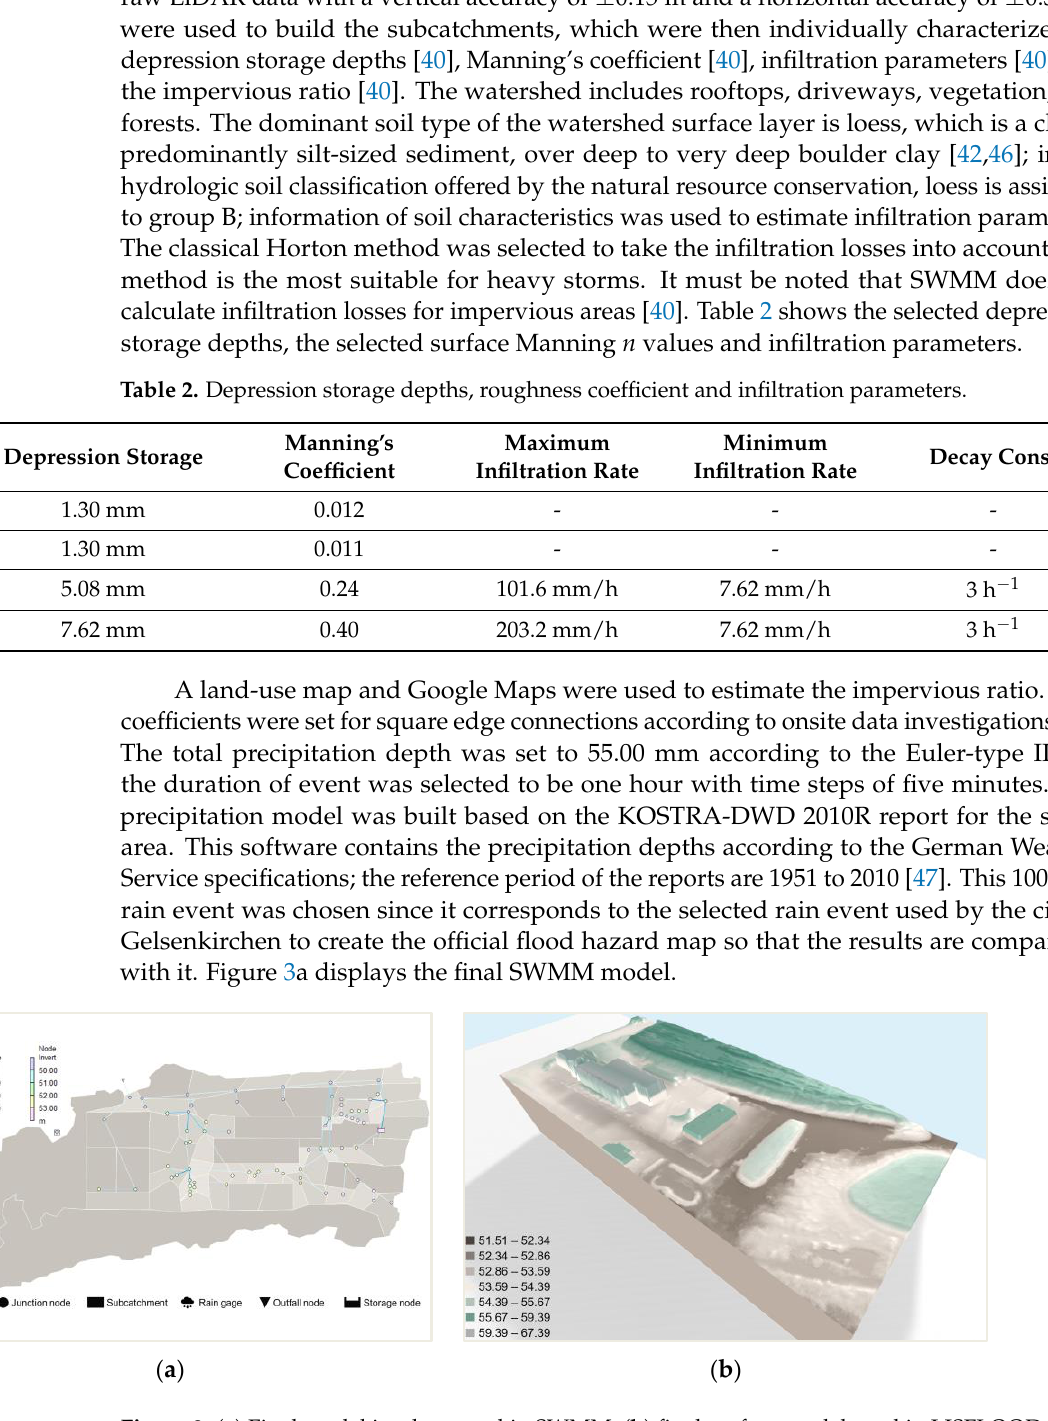
Figure 3. ( a ) Final model implemented in SWMM; ( b ) final surface model used in